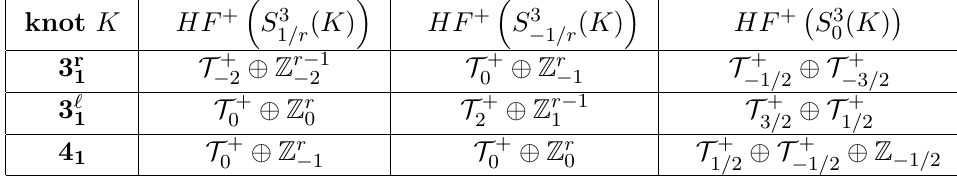
(cid:16) (cid:17) S 3 ( K ) with r ! 1 1 =r